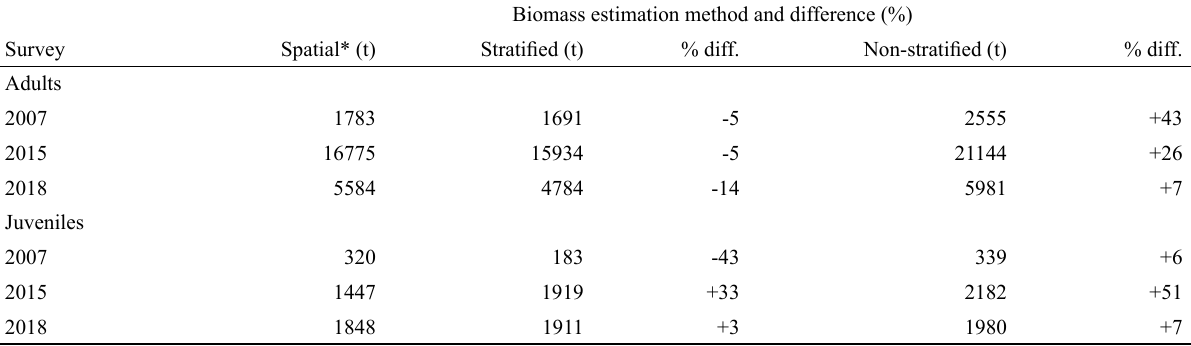
Table 3. – Comparison of biomass estimations from the best*spatial interpolation model and from the stratified and non-stratified design